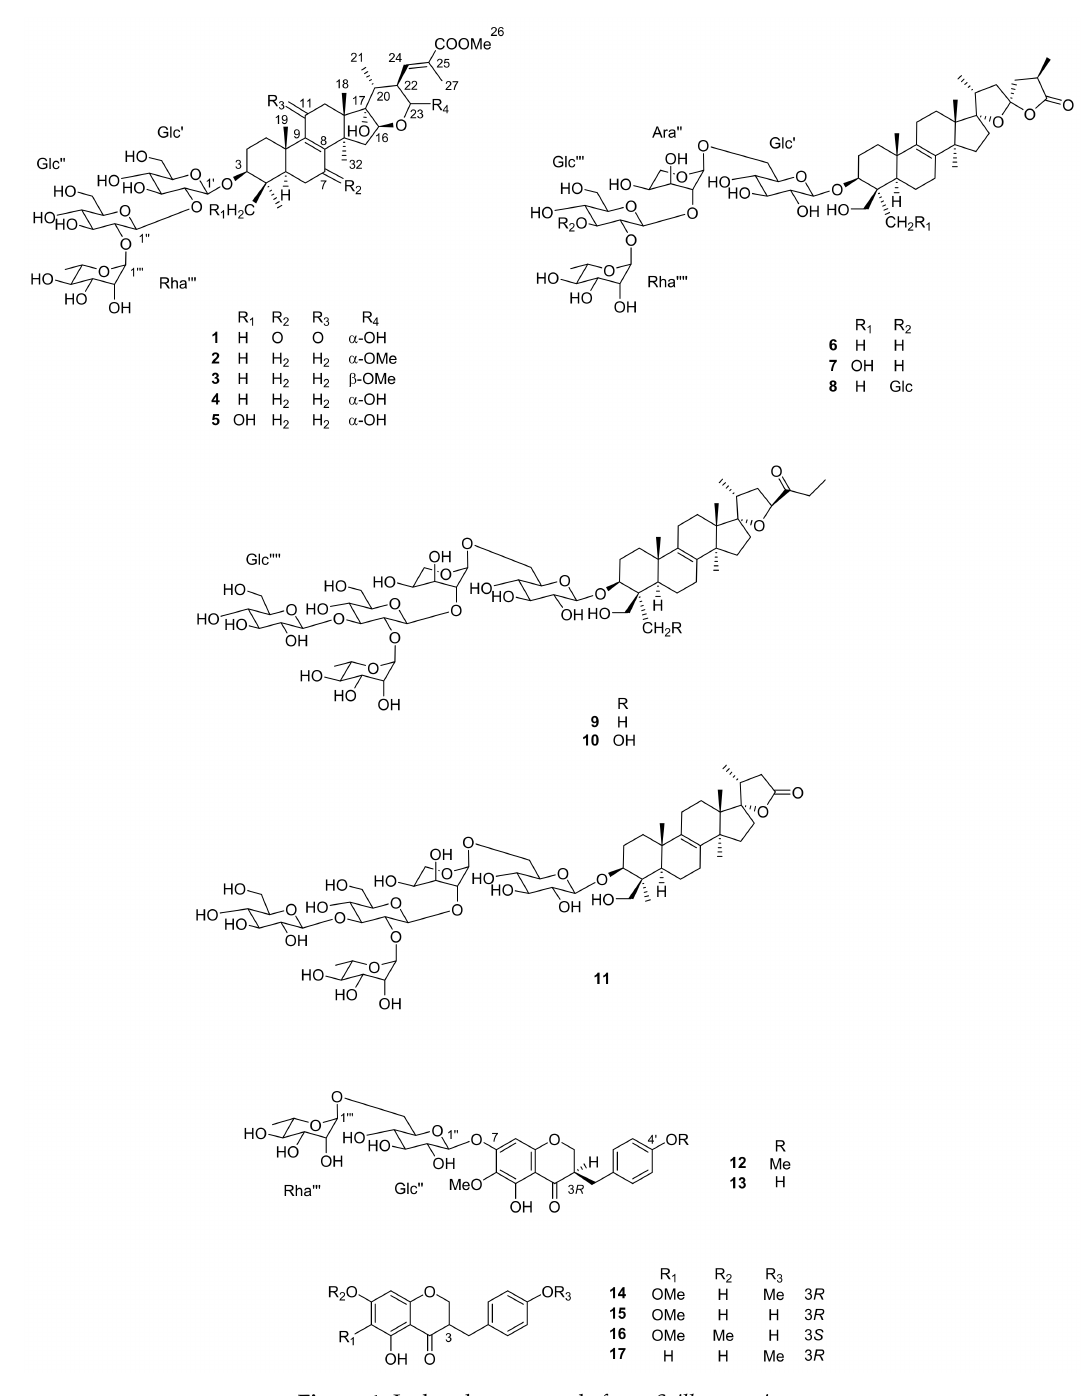
Figure 1. Isolated compounds from Scilla peruviana